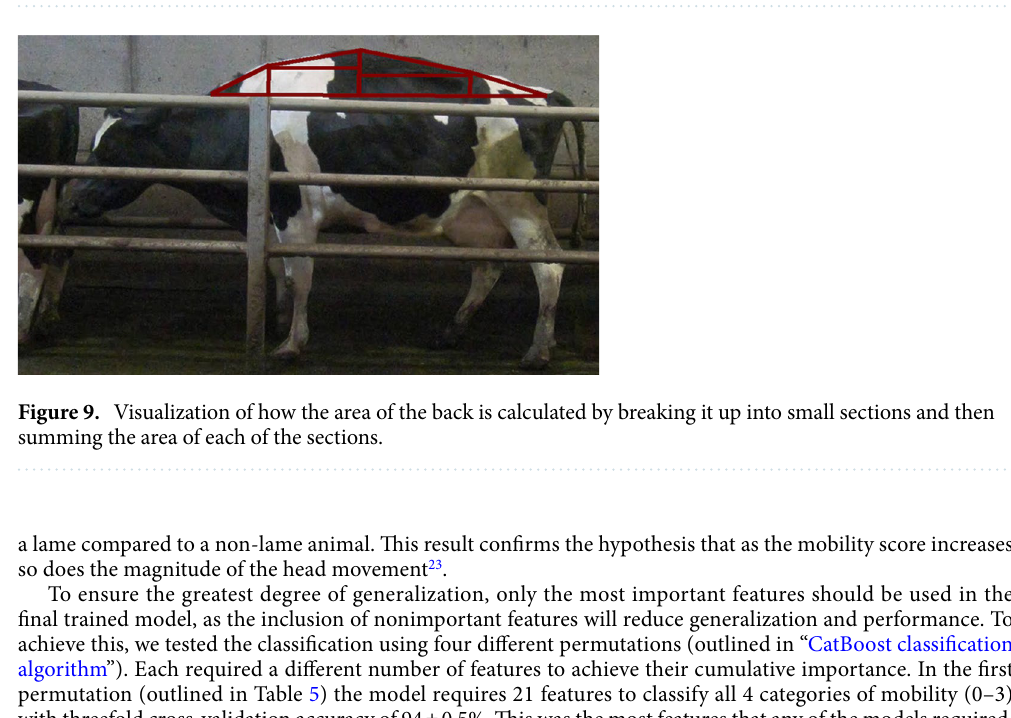
Figure 8. Root mean squared errors of each of the cows calculated using Eq. (1). The severely lame cow in the centre of the image shows a significantly higher score than that of the mildly lame cow (left) and sound cow (right).